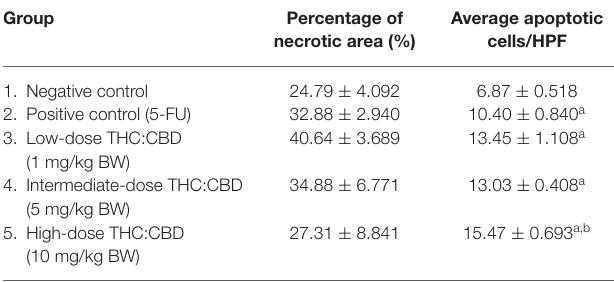
TABLE 3 | The percentage of necrotic area and the average apoptotic cells. Group Percentage of Average apoptotic necrotic area (%)